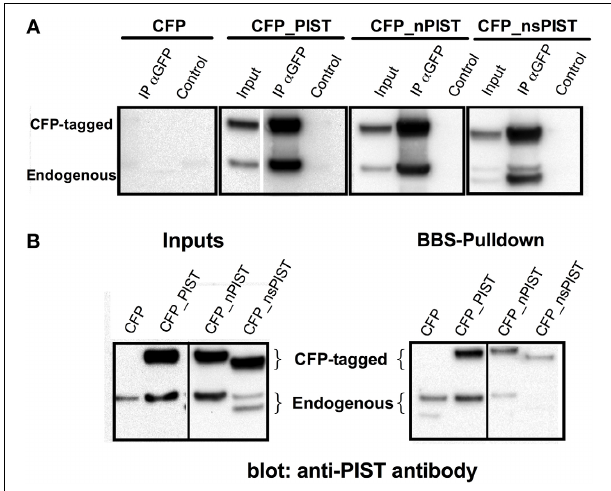
FIGURE 3 | (A) Heteromerization of long and short forms of PIST. (A) GFP antibody was used to precipitate CFP-tagged PIST isoforms out of lysates of transfected HEK293 cells. PIST isoforms were detected using a polyclonal antibody against PIST. Bands compatible with both the GFP-tagged forms and with endogenousPIST were detected, indicating association between the transfected CFP-PIST and the endogenousone. (B) Co-precipitation of PIST isoforms with K V 10.1_BBS. Lysates of KV10.1_BBS-expressing cells were labeled with an α -BTX-biotin conjugate and pulled down with streptavidin-coated beads (see Figure 1 ). Anti-PIST specific antibodies detected co-immunoprecipitation of bands compatible with the corresponding CFP-tagged form, together with an endogenous PIST